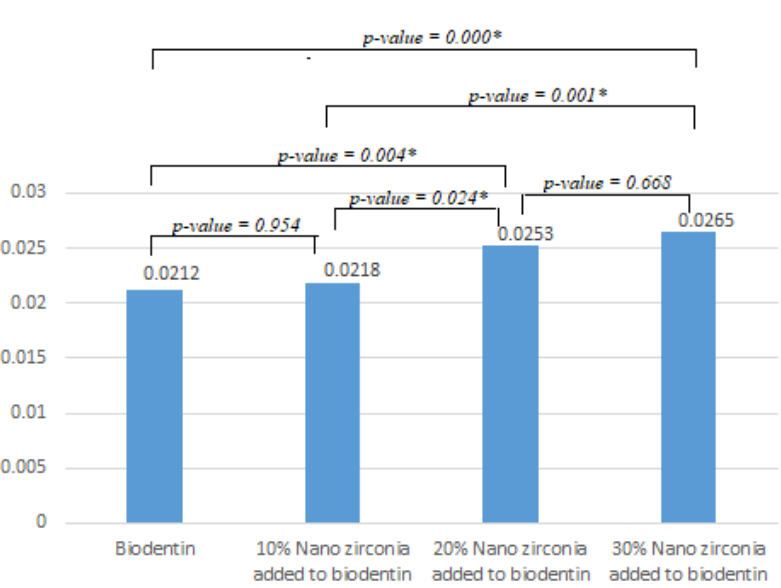
Figure 3. Solubility between different groups. * significant difference.